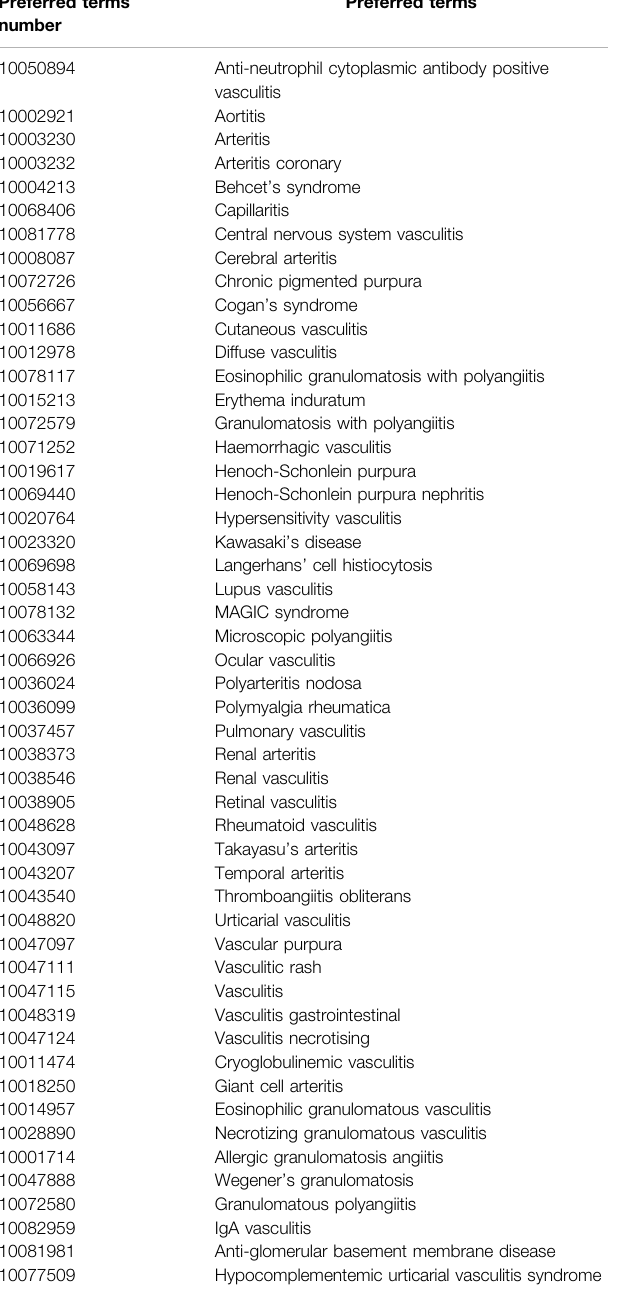
TABLE 1 | Preferred terms of